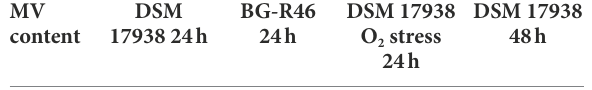
TABLE 1 Quantification of L. reuteri derived extracellular membrane vesicles (MV) and their content of DNA, RNA, and